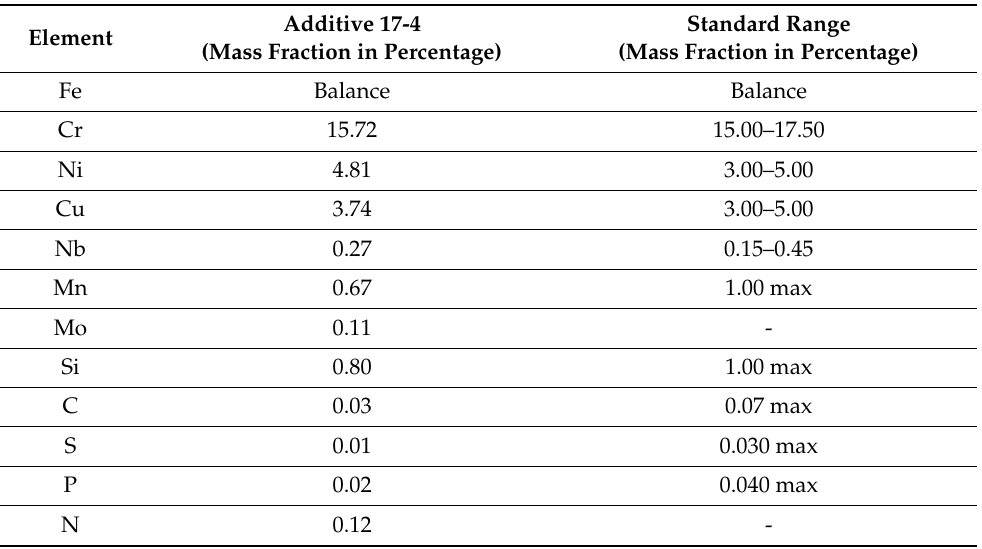
Table 1. Measured composition of 17-4 powders used in this work and the allowable range of composition in mass